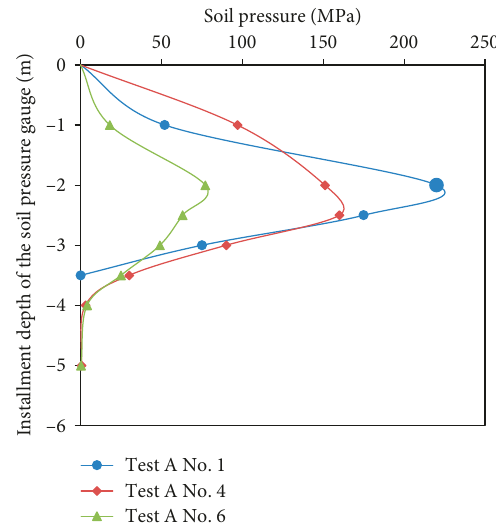
Figure 9: Variation of soil pressure with installment depth for Test A.